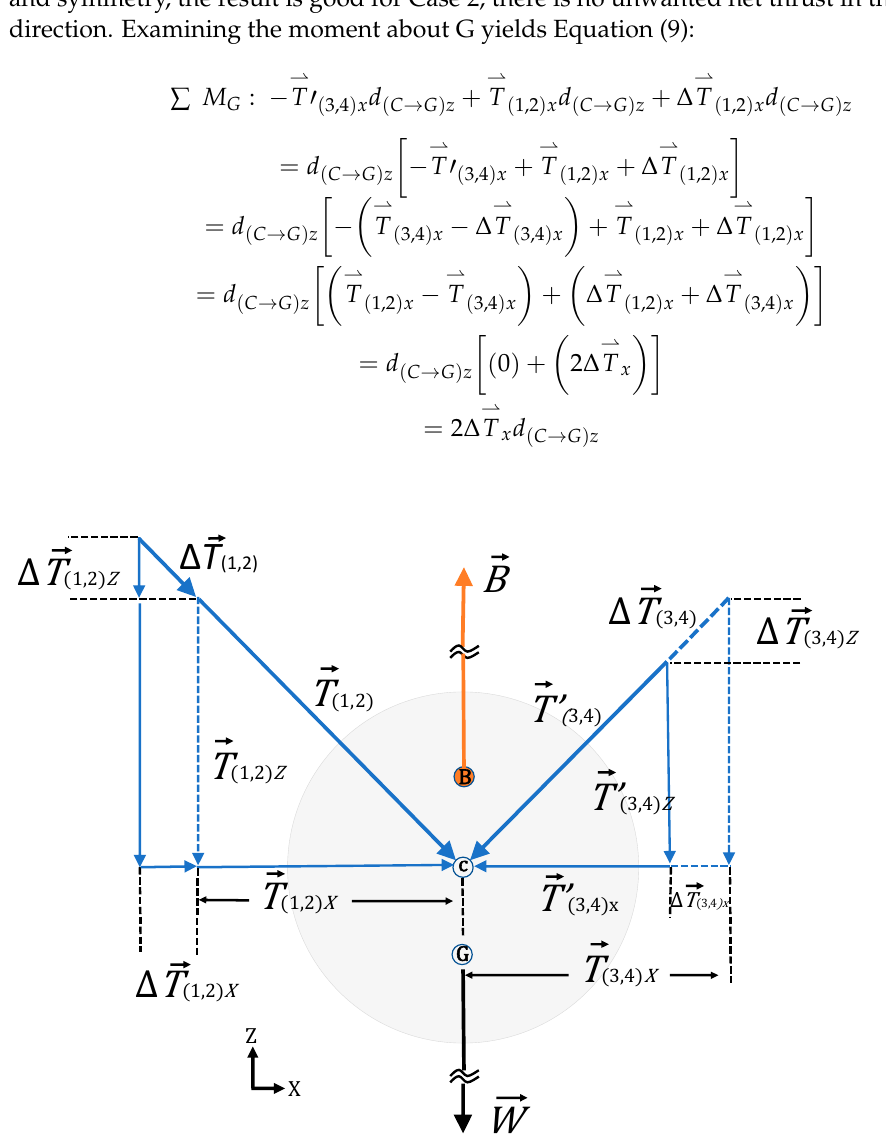
Figure 5. Case 2: Balanced thrust increase.